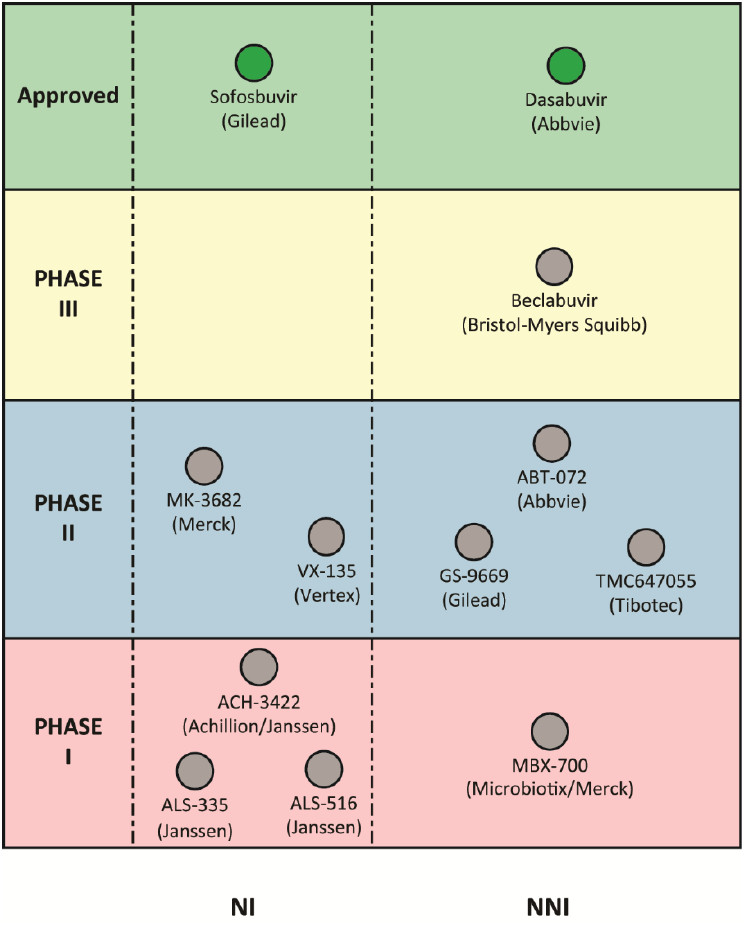
Figure 2. Direct-acting antivirals targeting the HCV RdRp in clinical development.A summary of DAAs targeting the HCV RNA dependent RNA polymerase (RdRp) in different stages of clinical trials is shown along with the developing companies. RdRp inhibitors are divided into nucleoside (NI) and non-nucleoside inhibitors (NNI). Compounds that are in different phases of clinical trials are shown as grey spheres, while those that have been approved for clinical use are shown as green spheres.